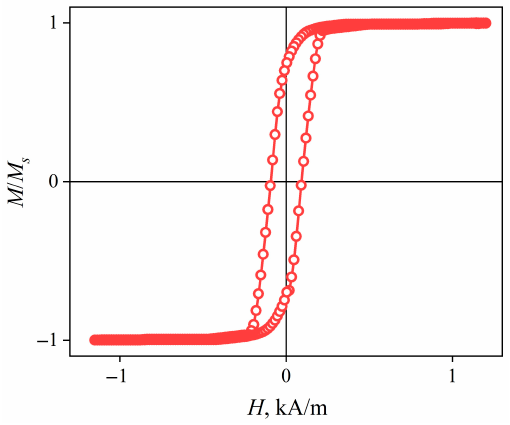
Figure 7. Hysteresis loop of an amorphous wire Co 66 Fe 4 Nb 2.5 Si 12.5 B 15 .